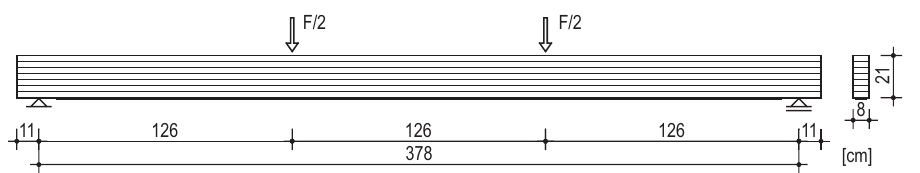
Fig. 1. Bending test configuration